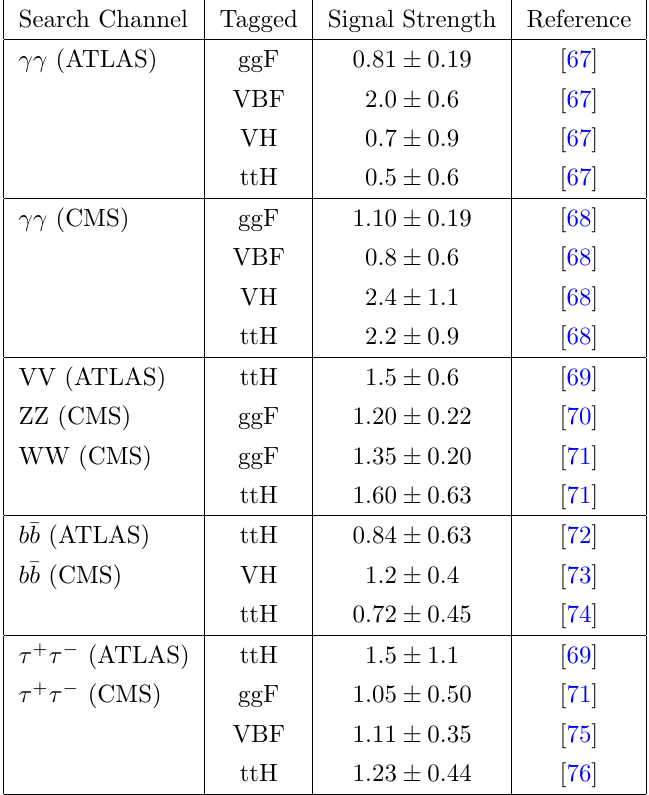
Table 2 . The LHC Run II Higgs data employed in this work. The \Tagged" column displays the production mode of the Higgs boson: gluon fusion (ggF), vector boson fusion (VBF), associ- ated production with a vector boson (VH) and associated production with a pair of t (cid:22) t (ttH). All uncertainties shown above are